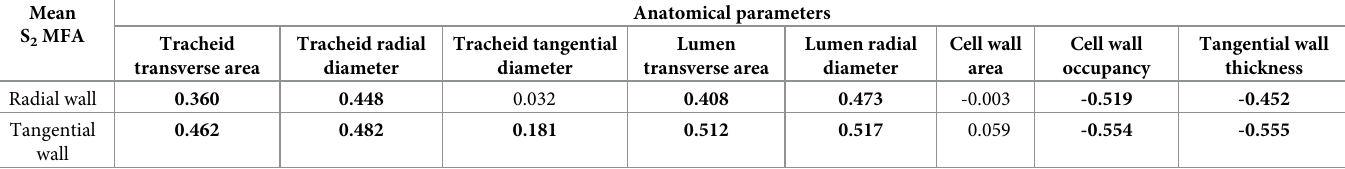
Table 1. Correlation coefficients between anatomical parameters and S 2 microfibril angle